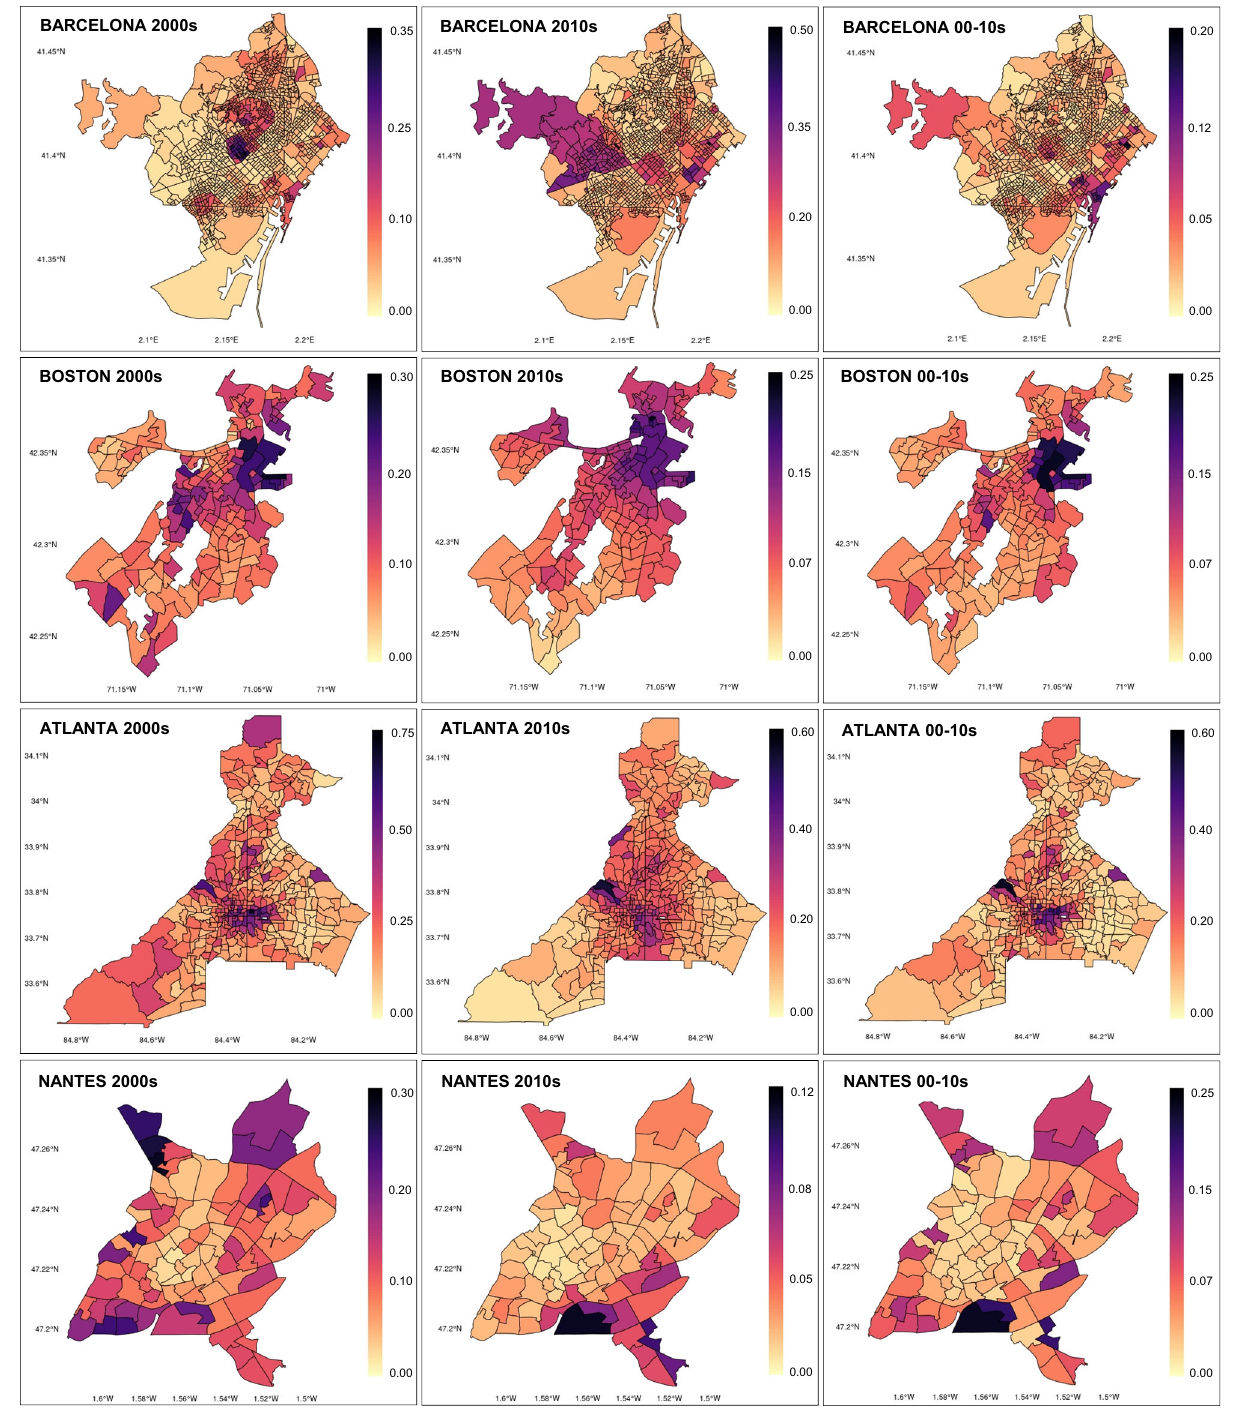
Fig. 5 Mean of posterior predictive distributions in Barcelona, Boston, Atlanta, and Nantes. The Bayesian posterior predictive distributions refer to the distributions of the power in predicting the gentri fi cation index (outcome variable) in each census tract (or equivalent) produced by the fi nal model (model that includes spatial effect and selected independent variables). They are not to be interpreted as traditional p -values (the probability of obtaining the observed results, assuming that the tested null hypothesis is true). Darker (darker pink, purple, and black) polygons show areas of the city where the fi nal spatial effect model best predicts the relationship between greening and gentri fi cation while lighter polygons (from light yellow and orange) show the areas where the fi nal spatial effect least predicts that relationship. Because these are all green gentri fi cation cities, high explanatory values (darker pink, purple, and black polygons) also indicate areas where green gentri fi cation has occurred with higher likelihood. Selected cities include integrated (Barcelona, Boston) and lead (Atlanta, Nantes) green gentri fi cation cities and include cases where the scope of green gentri fi cation differs across time periods. Especially for lead green gentri fi cation cities, the maps are largely indicating the speci fi c geography of green gentri fi cation. For integrated green gentri fi cation cities, the maps are showing the geography of gentri fi cation driven by a mix of factors. For example, in Nantes, for gentri fi cation in the 2010s, the model best predicts high gentri fi cation in the area of the Ile de Nantes (black polygon), and the surrounding areas of Vieux Malakoff, Malakoff, Champ de Mars, and Nantes Sud (darker pink and purple polygons) in the bottom center map. NATURE COMMUNICATIONS| (2022) 13:3816